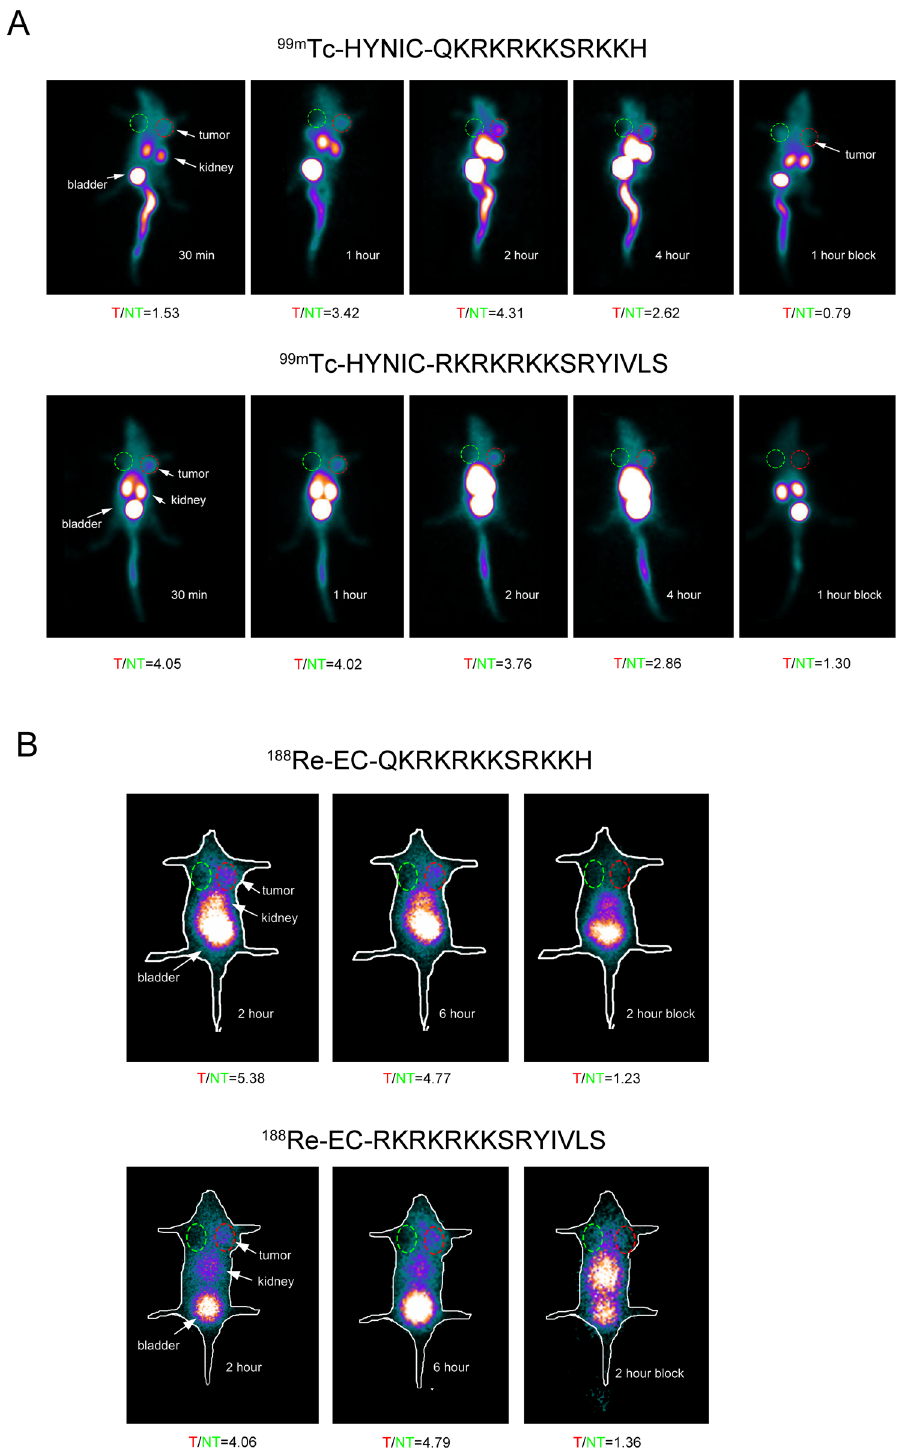
Figure 5. SPECT planar imaging of A549 tumor-bearing nude mice following the injection of 99m Tc/ 188 Re- labeled peptides. Images were acquired at 0.5, 1, 2, 3, and 4 h following injection of the 99m Tc-HYNIC-peptides or at 2 and 6 h following the injection of the 188 Re -EC-peptides. The tumor sites were clearly detected following injection (indicated by arrows on the image). Competitive binding was assessed as the absence of detection at 1 or 2 h following injection. Tumor/non-tumor (T/NT) ratio was showed below each